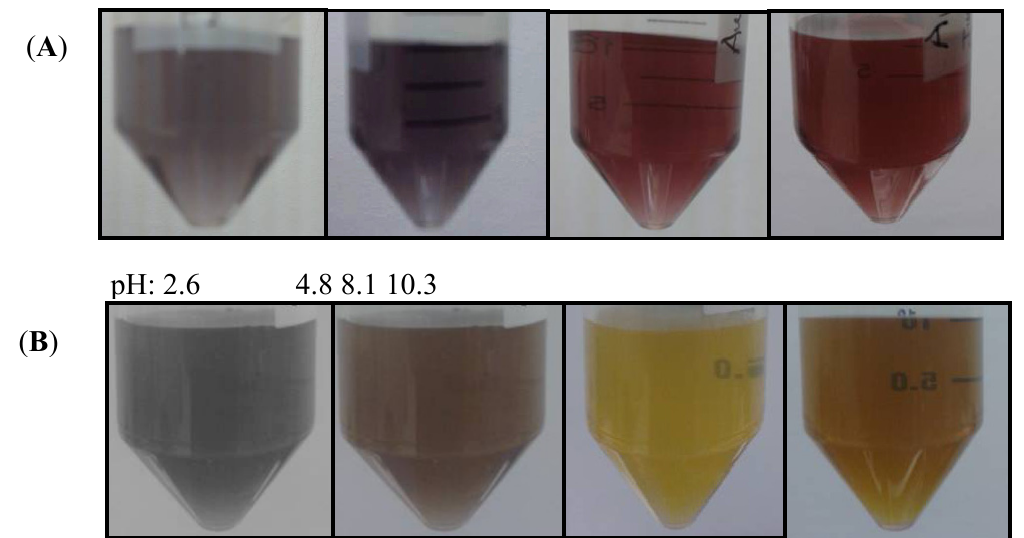
NPs suspensions; ( B ) Ag NPs suspensions.